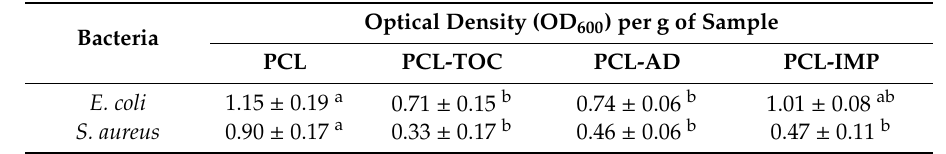
Table 5. Antimicrobial activity of PCL-based films performed by optical density method (OD 600 ) after 16 h of incubation against E. coli and S. aureus